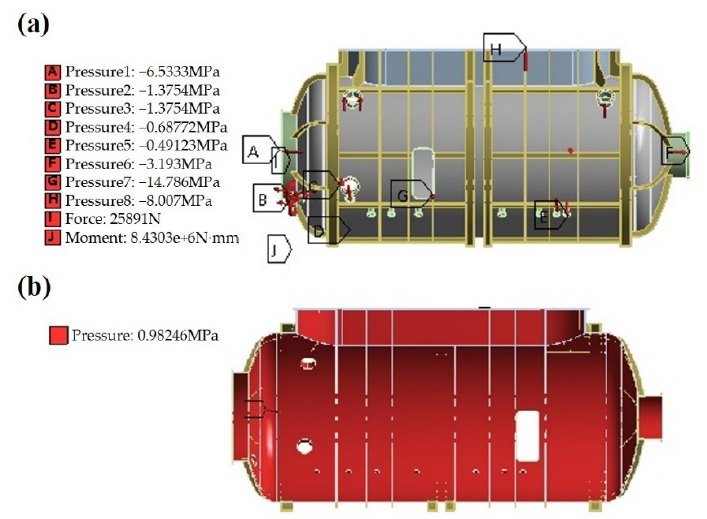
Figure 8. Illustration of load application: ( a ) equivalent pressure load and pipeline thrust load on tubes; ( b ) pressure load of the test cabin and tubes.